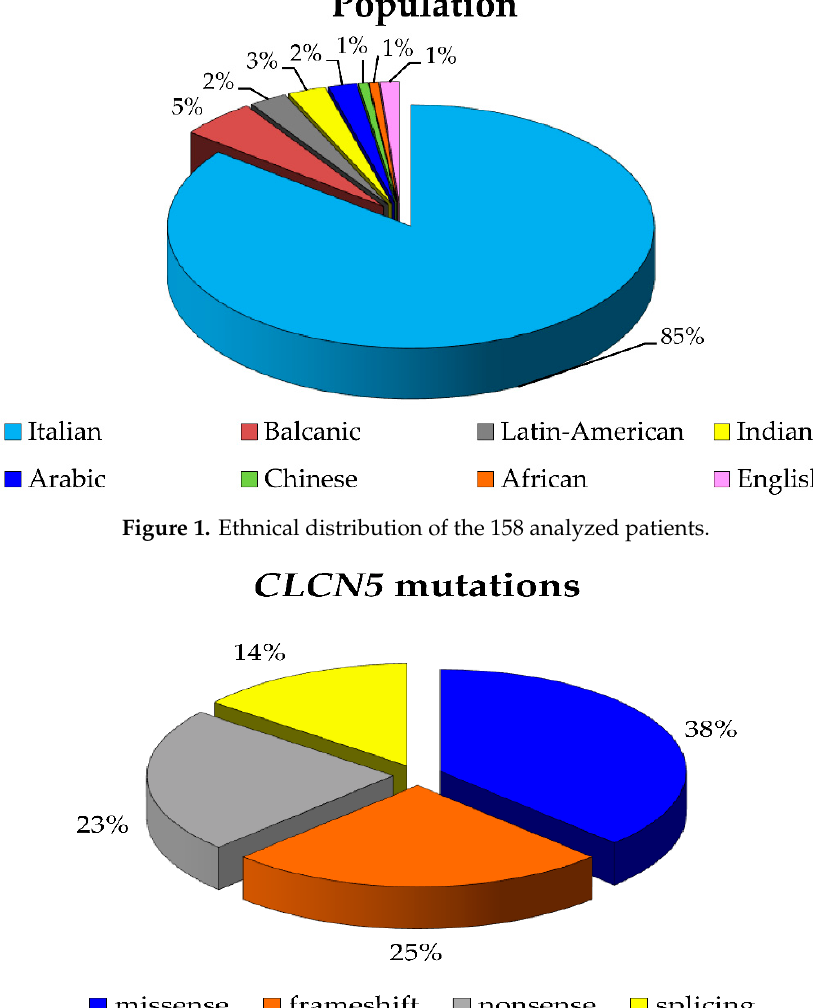
Figure 2. Percentages of mutations of CLCN5 gene by type. Table 1. Novel mutations in the CLCN5